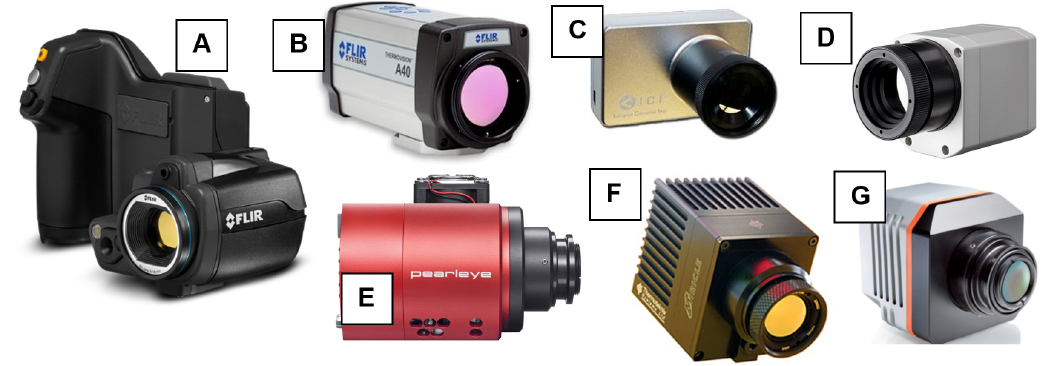
Figure 9. Currently available thermal cameras, listed in Table 6: ( A ) FLIR T450sc; ( B ) FLIR Thermovision A40M; ( C ) ICI 7640 P-Series; ( D ) Optris PI400; ( E ) Pearleye LWIR; ( F ) Thermoteknix MIRICLE 370 K; ( G ) Xenix Gobi-384 (Scientific). Table 6. Some of the currently available thermal cameras, after Khanal et al. [29],